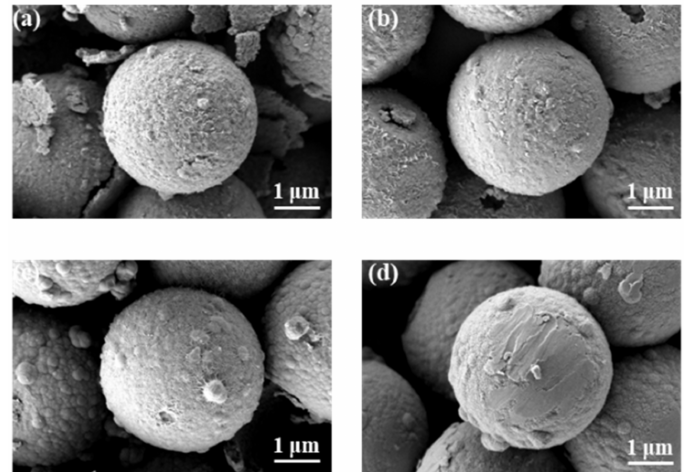
Figure 12. Image of metal coating surface changed according to pH: ( a ) image of conductive ball coated with metal at pH 4.2, ( b ) image of conductive ball coated with metal at pH 4.7, ( c ) image of conductive ball surface with metal coating at pH 5.2, and ( d ) image of conductive ball with metal coating at pH 5.7.